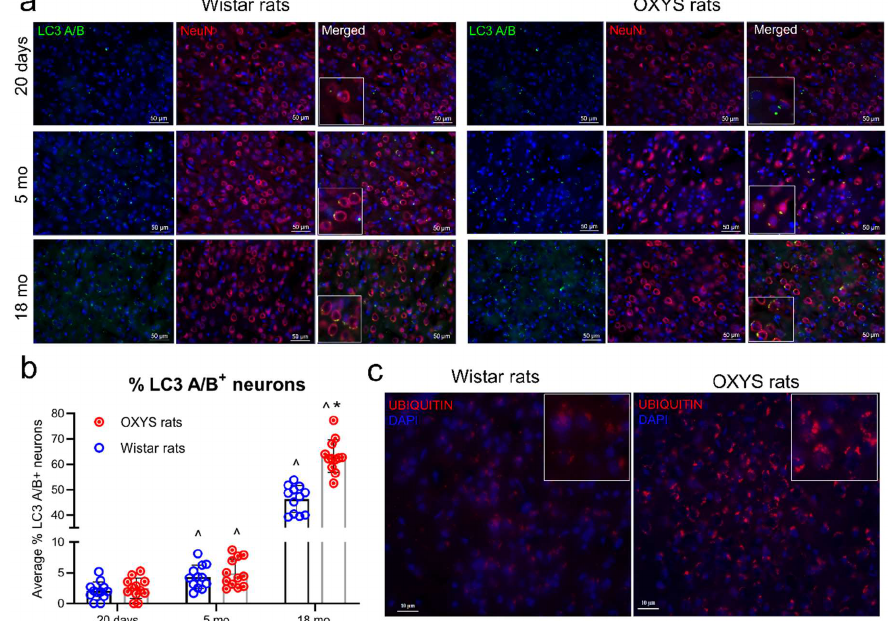
Figure 3. LC3 A/B expression in the Wistar and OXYS rats cortex at different ages. ( a ) Representative images of cortex cryosections immunostained for LC3 A/B (green) and the colocalization of LC3 A/B fluorescent dots with a marker of neurons (NeuN; red) in OXYS and Wistar rats. ( b ) Quantitative analysis yielded an increasing number of LC3 A/B + neurons with age in both rat strains. ( c ) Immunofluorescence of ubiquitin signals was greater in the cerebral cortex of 18-month-old OXYS rats than in age-matched Wistar rats. Data are presented as mean ± SD, n = 4 (with three sections per animal). * Interstrain differences, ^age-associated differences; p < 0.05.